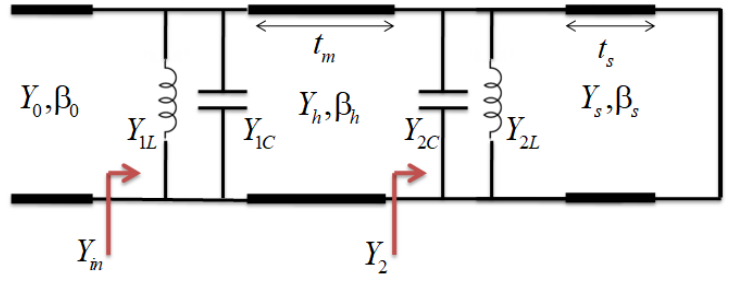
Figure 2. The circuit model equivalent to the proposed structure in Figure 1.